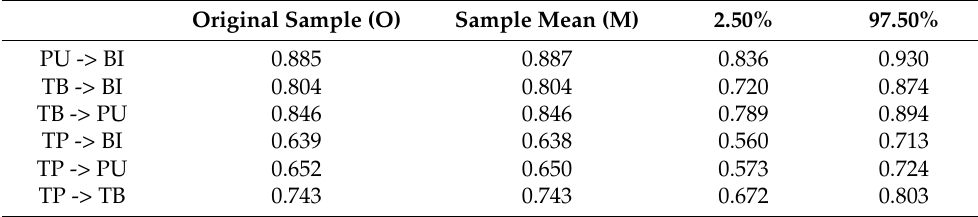
Table 6. HTMT inference.